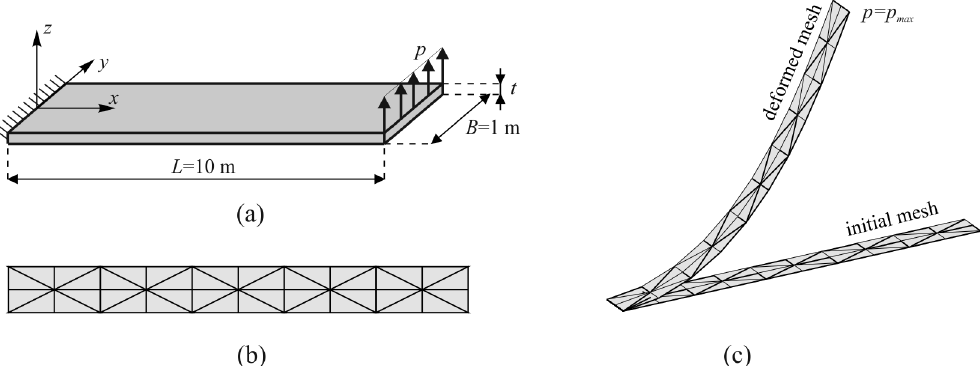
Figure 17. Cantilever exposed to line force at the free end: ( a ) geometry; ( b ) discretisation; ( c ) deformed finite element mesh for the linear material behaviour under the maximum force.